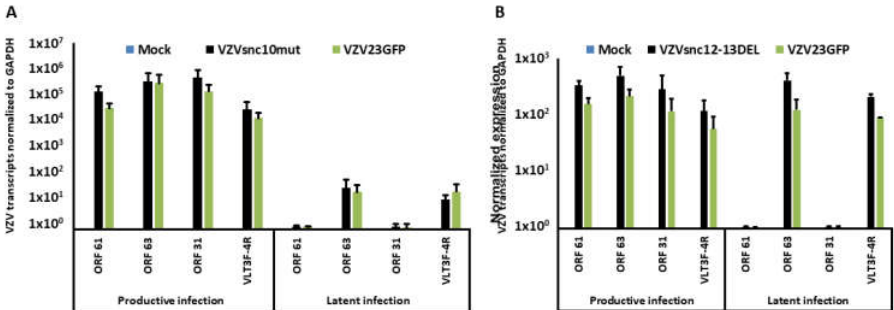
Figure 5. VZV mutant in VZVsncRNAs establishes experimental latency in hESC-derived neurons. ( A ) hESC-derived neurons were infected with 100 PFU of cell-free VZV. Latent infections were obtained by treatment with ACV (see methods for exact protocol). In the absence of ACV, all three viruses infected neurons productively (see Figure 4). RNA was harvested at 5 dpi from the wells not treated with ACV and at 25 dpi from presumably latently infected neurons in wells treated with ACV and lacking GFP expression. RT-qPCR analysis for IE transcripts ORF61 and ORF63, late transcript ORF31, and transcripts of VLT exons 3 and 4 of VLT VLTexon3–4 (4) was then performed. ( A ) VZVsnc10mut productively infected neurons (left 4 sets of bars) when not treated with ACV. ACV-treated latently infected wells (right 4 sets of bars) expressed very low levels of ORF61 and late transcript ORF31 consistent with our previous report [6]. The only transcripts detected at higher levels were those of VLT exons 3 and 4 of VLT (VLTexon3–4) (4) and a portion of ORF63 that is co-expressed with VLT [7] consistent with the establishment of latency. N = 3 independent experiments. ( B ) RT-qPCR analysis of ACV-untreated, productively infected (left 4 sets of bars) and ACV-treated, latently infected (right 4 sets of bars) neurons infected with VZVsnc12-13DEL revealed the same expression patterns of transcripts as observed for infections with VZVsnc10mut. That is, neurons productive infected with VZVsnc12-13DEL expressed all 4 tested transcripts at high levels, while the latently infected neurons only expressed transcripts expected to be present in latency. Results show the average expression levels from 3 independent experiments normalized to the expression of GAPDH.